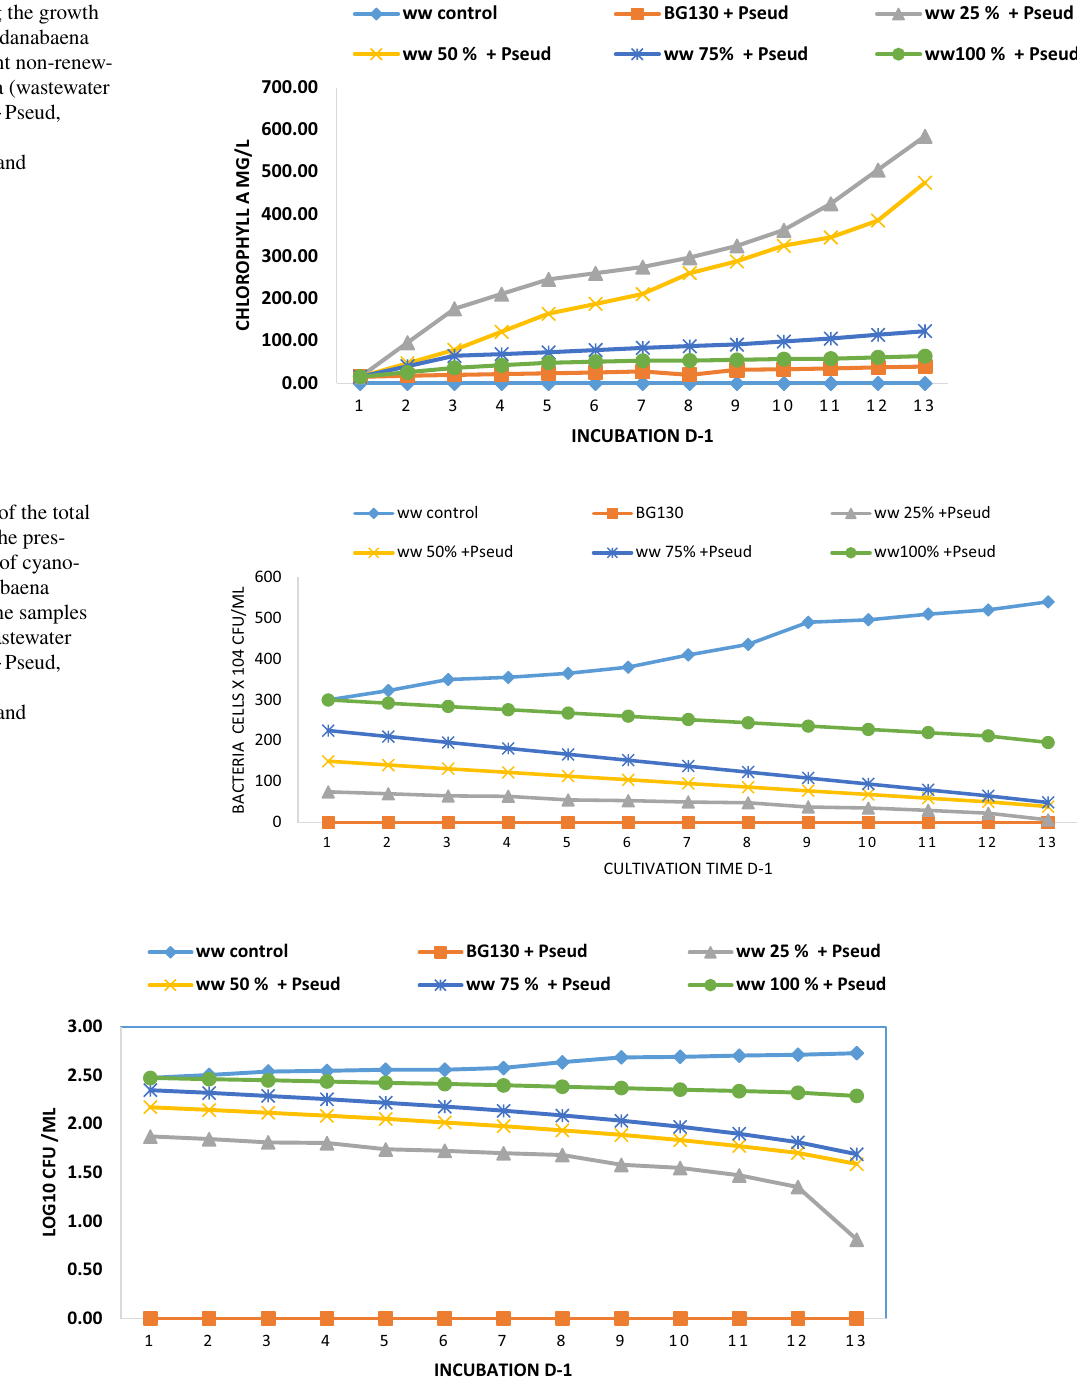
Fig. 6 Behaviour of the total bacterial flora exponential growth in the presence and absence of cyanobacteria Pseudanabaena galeata on the same samples of experiment (wastewater control, ww25% + Pseud,ww50% + Pseud, ww75% + Pseud, and ww + The temporal evolution of heterotrophic bacteria was enumerated, by indirect count of CFU, on nutrient (PCA) incubated at 37.5 °C for 24 h. The rate of cell growth is determined by the formula: